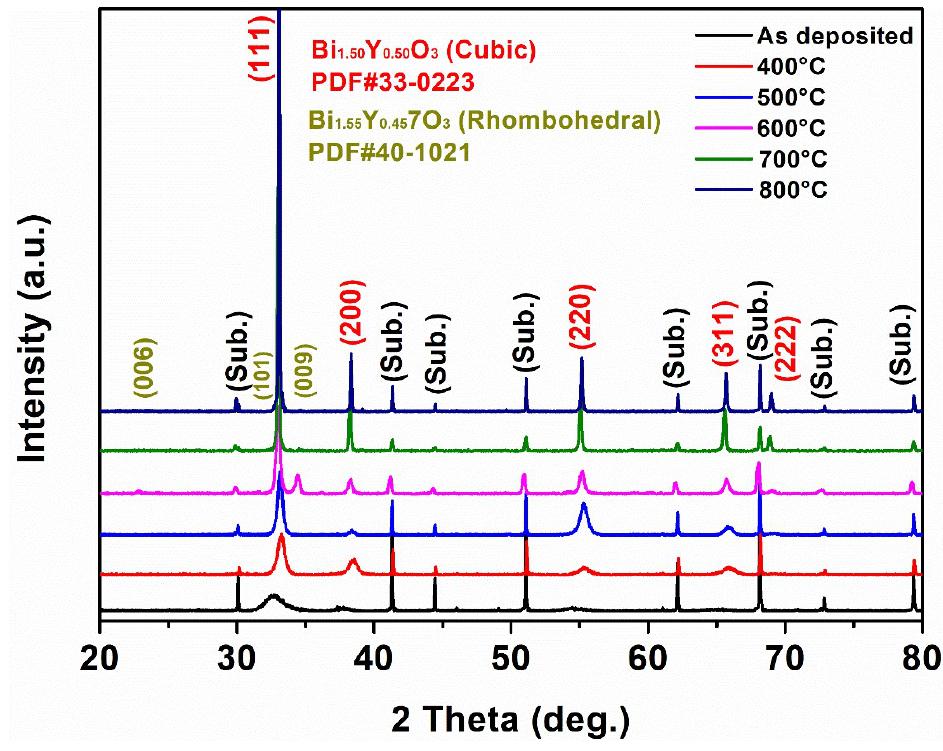
Figure 6. The XRD characterization of the Bi 1.5 Y 0.5 O 3 films varies with the different annealing temperature. Table 2. The crystallite size of Bi 1.5 Y 0.5 O 3 films varies with the different annealing temperature from XRD characterization.